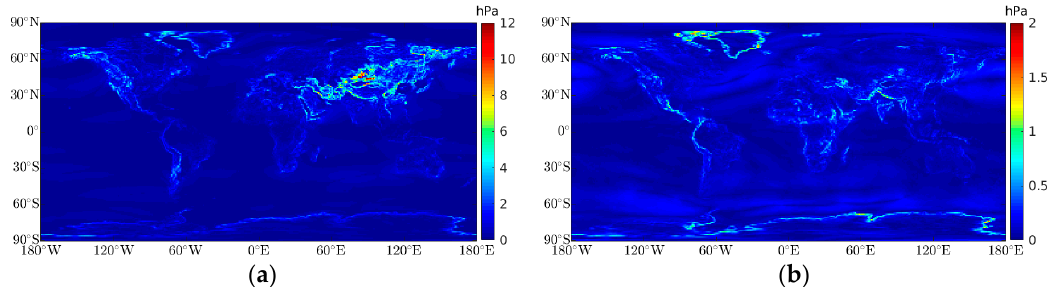
Figure 5. Maximum spatial variability for each surface pressure periodicity, which were calculated using a window of 4 × 4 grid points, approximately a 1° × 1° horizontal grid: ( a ) maximum spatial variability for the annual amplitude (hPa) and ( b ) maximum spatial variability for semi-annual amplitude (hPa).